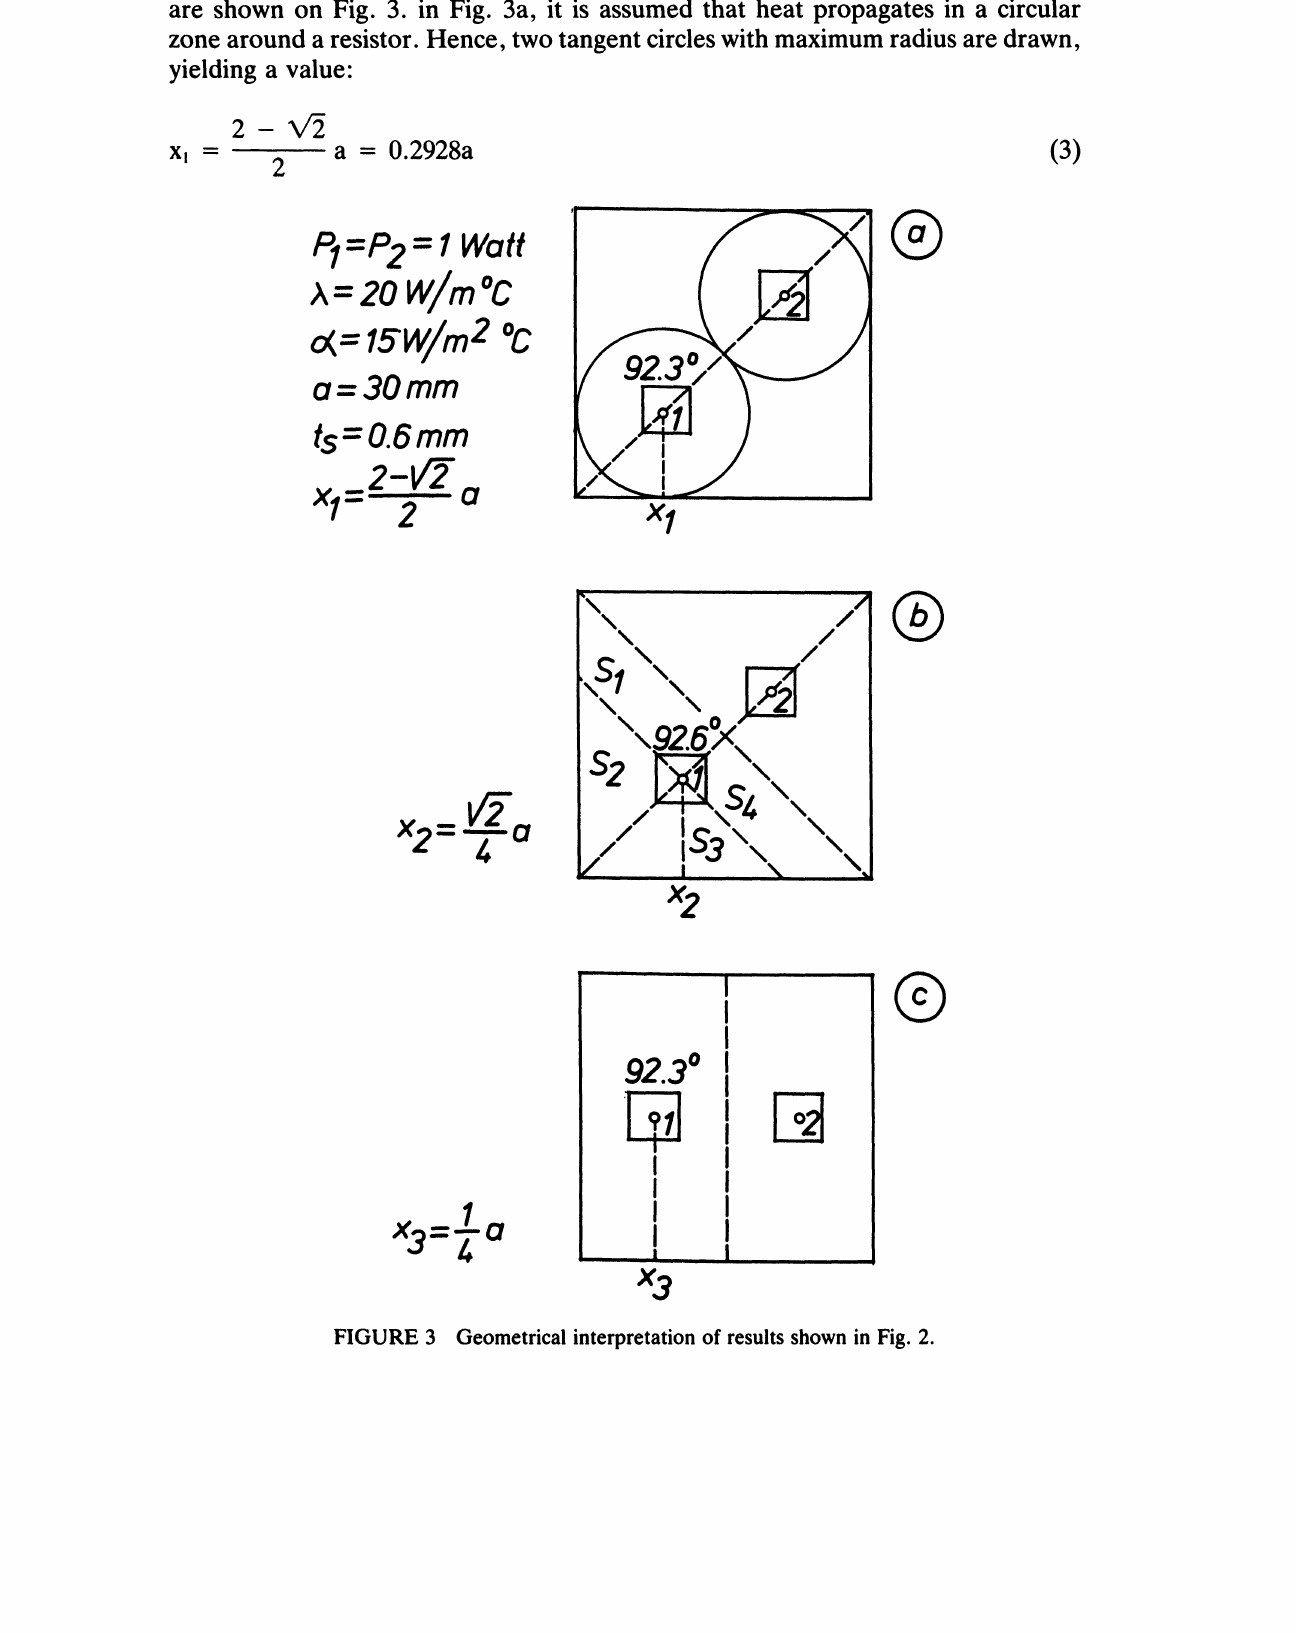
FIGURE 3 Geometrical interpretation of results shown in Fig.